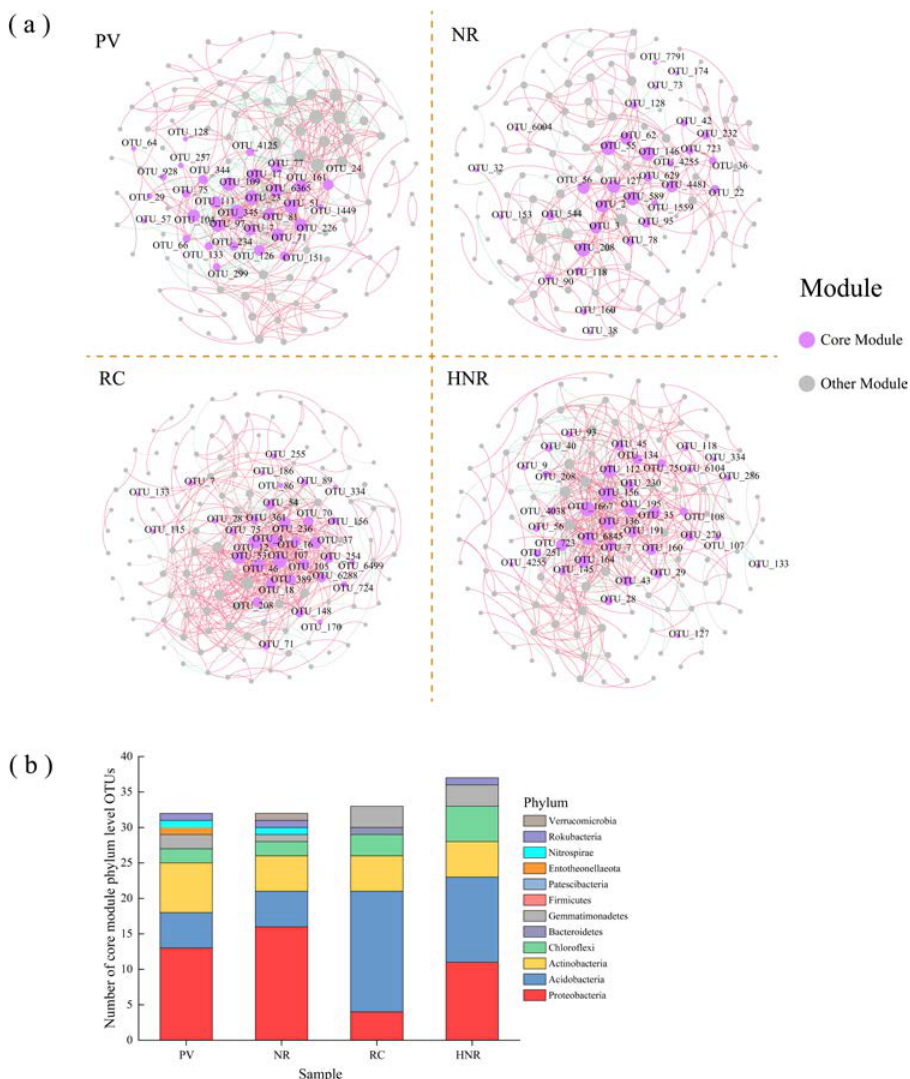
Figure 10. Histogram of microbial molecular ecological networks based on the core module ( a ) and the community distribution under the core module phylum ( b ).